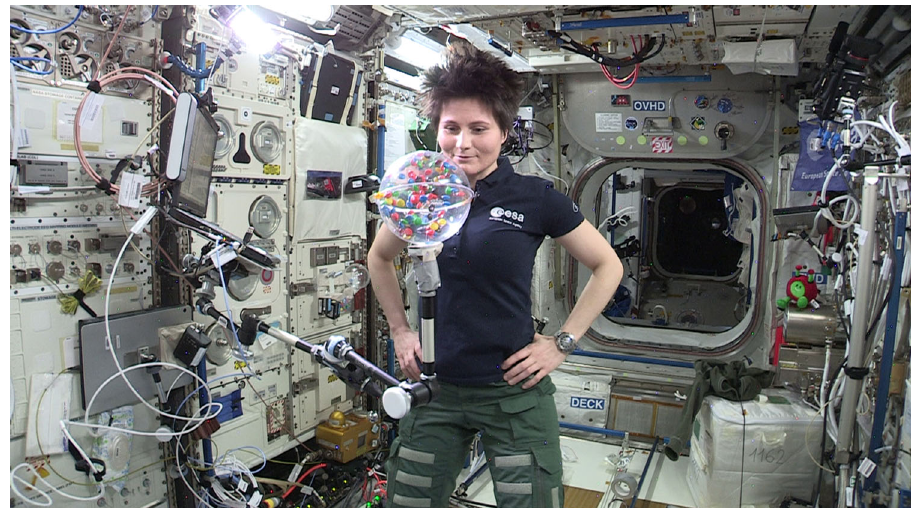
Fig. 1 Experiment in ISS. Astronaut Samantha Cristoforetti conducting the experiment on board the ISS during Expedition